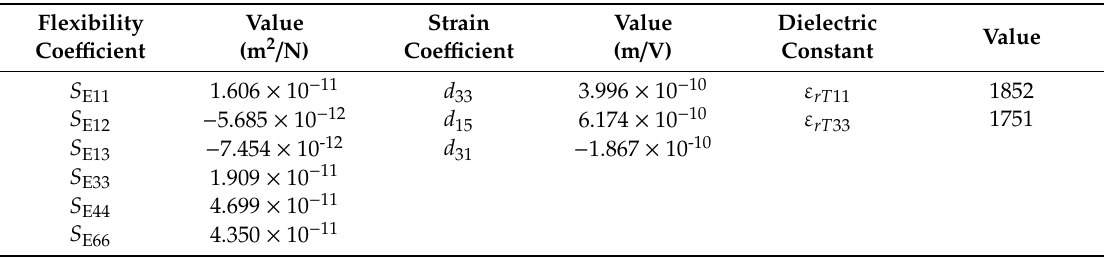
Table 1. The Coe ffi cient summary of Strain-Charge